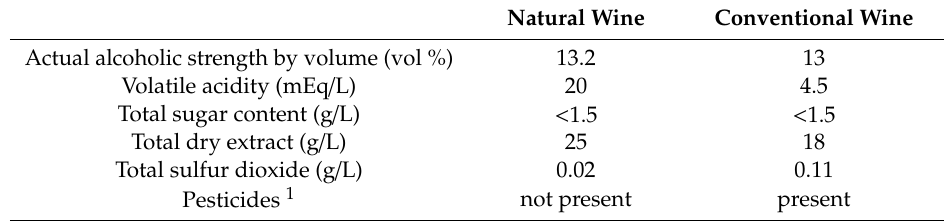
Table 1. Characteristics of the natural and conventional wines